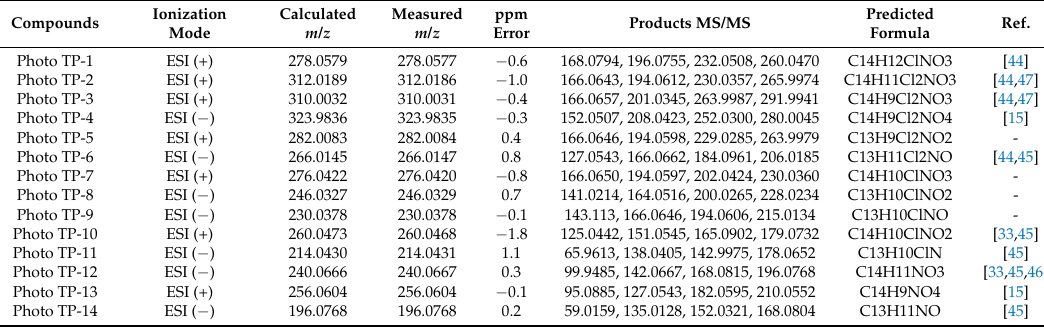
Table 1. DCF photo-transformation products detected by UPLC/ESI–QTOF–MS IDA.